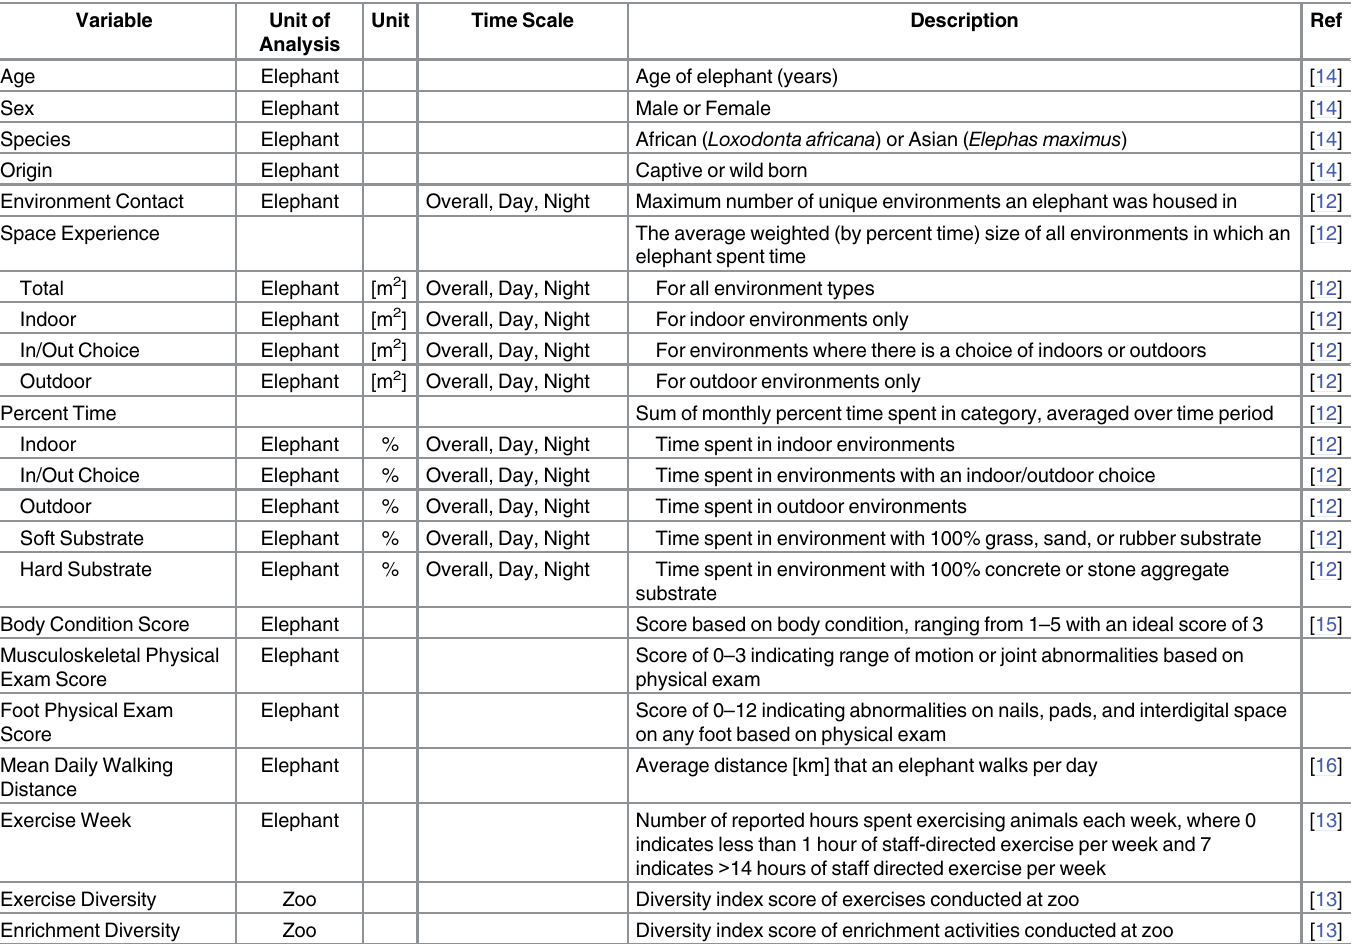
Table 1. Description of variables used in analysis of musculoskeletal and possible persistent foot score analysis of African and Asian elephants.